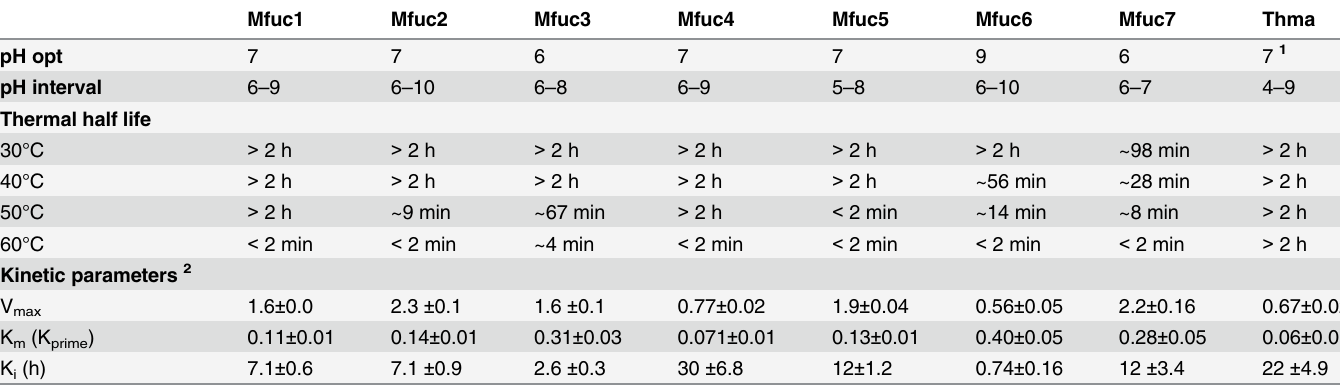
Table 2. Properties of metagenome-derived α -L-fucosidases and Thma.